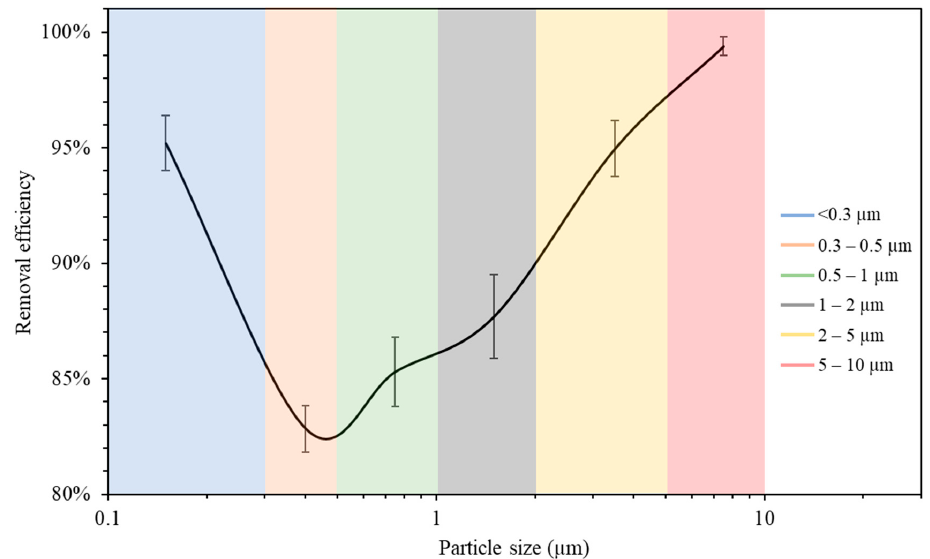
Figure 7. Air purifier removal efficiency as a function of particle size. The error bars indicate standard deviations of values measured in a single day. Values in x-axis are the mid-point diameters of each particle size range.